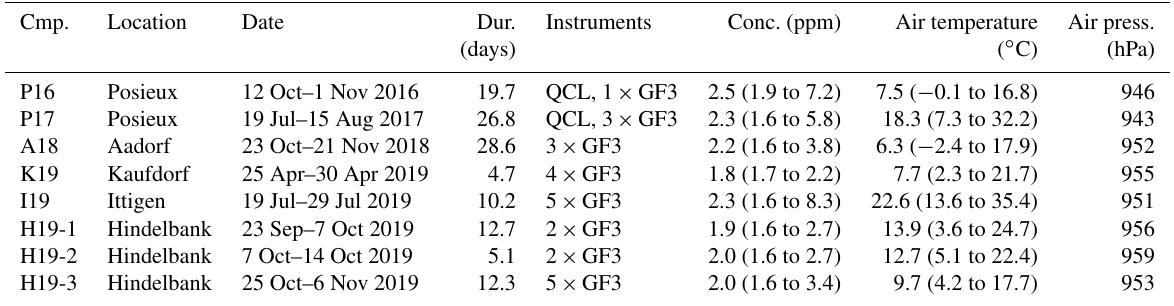
Table 2. Characteristics of the intercomparison campaigns (Cmp.). Dur.: duration of the campaign. Conc.: measured average (minimum and maximum) concentration. Air temperature: average (and minimum, maximum) values. Air press.: average air pressure.